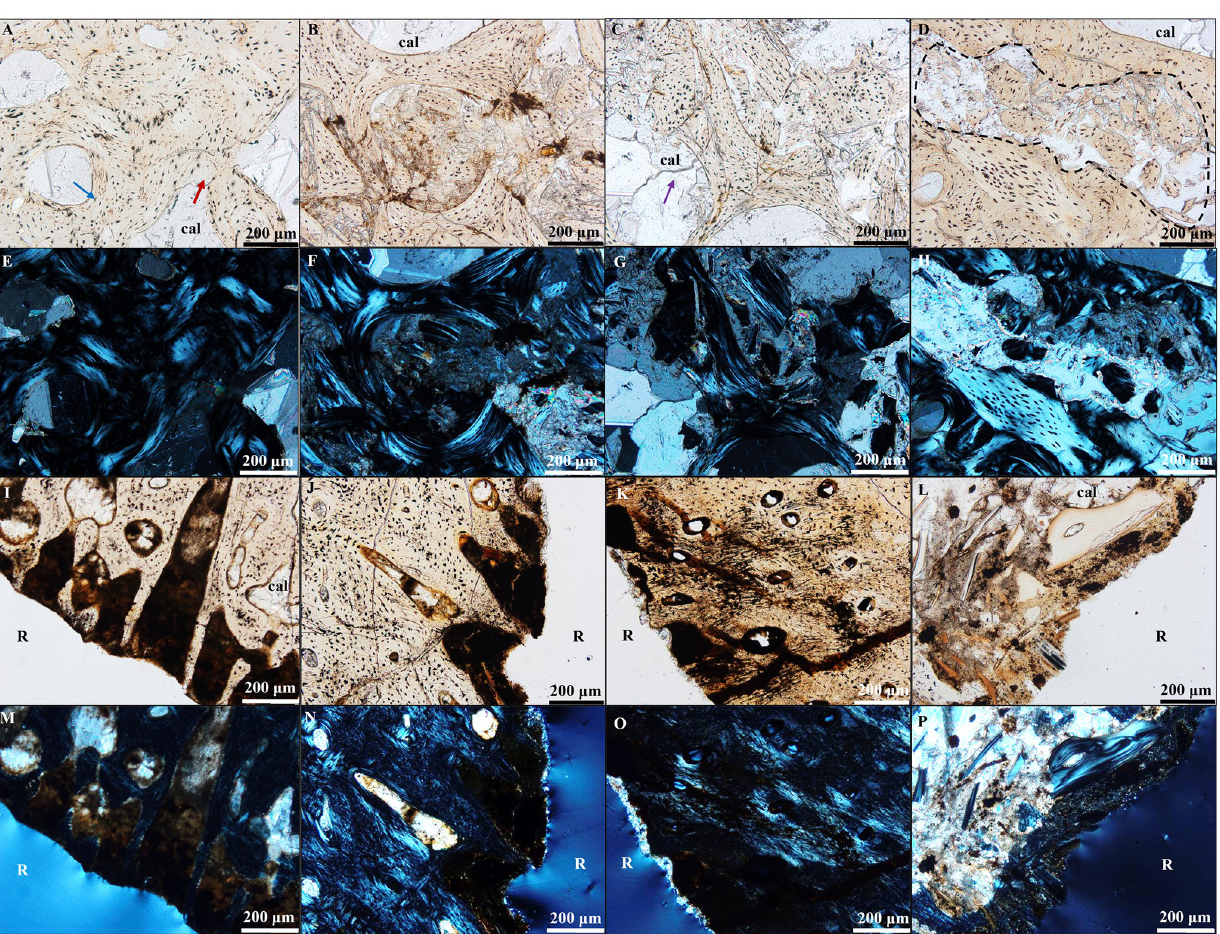
Fig 4. F1 pre-dissolution, pH 6, pH 5, and pH 4 thin sections of cortical and trabecular bone. Degree of dissolution exhibited in trabecular (A-H) and cortical (I-P) bone thin sections of Fossil 1 (F1) viewed under plane polarized light (PPL) and cross polarized light (XPL). (A) Pre-dissolution PPL image of trabecular bone with relatively intact trabeculae (red arrow) and osteocytes (blue arrow). (B) At pH 6, trabecular bone exhibited with the lowest degree of damage to histologic structures, with increased damange under exposure to (C) pH 5. Degradation of secondary mineral infilling (purple arrow) in a marrow space is present as large cracks and breaks in the mineral, observed in the left of the image. (D) F1 dissolved at pH 4 PPL image of trabecular bone. The trabeculae show a high degree of degradation, evident by small (10’s of μ m-sized) bone fragments toward the center of the image (area surrounded by a dashed line). XPL images of trabecular bone (E) pre-dissolution, (F) after exposure to pH 6 solution, and (G) dissolved at pH 5, and (H) dissolved at pH 4. (I)Pre-dissolution PPL image of cortical bone with relatively intact histologic structures. (J) F1 dissolved at pH 6 PPL image of cortical bone with the lowest degree of damage to histologic structures. Dissolution can be observed at the margin of the fossil to the right of the image. (K) After exposure to pH 5 solutions, cortical bone exhibited increased degradation. (L) F1 dissolved at pH 4 PPL image of cortical bone with highest degree of degradation to histologic structures. XPL images of cortical bone (M) pre-dissolution, (N) after exposure to pH 6 solution, (O) dissolved at pH 5, and (P) dissolved at pH 4. Abbreviations: R, resin; cal, calcite.